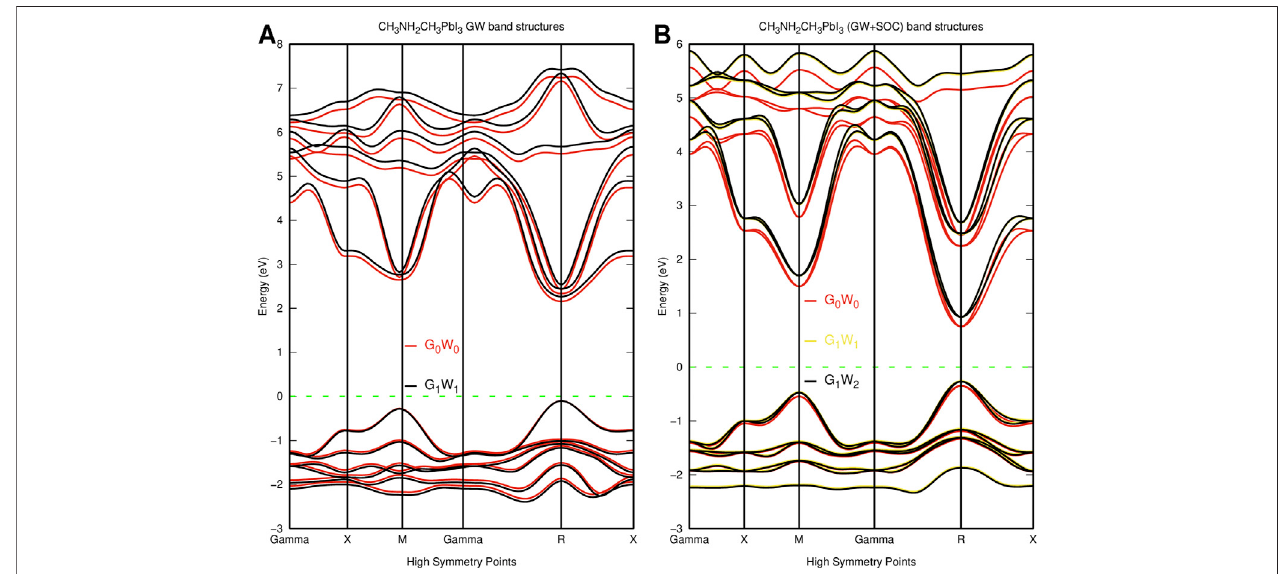
FIGURE 3 | GW band structure of pseudo-cubic CH 3 NH 2 CH 3 PbI 3 . (A) GW band structure of CH 3 NH 2 CH 3 PbI 3 . (B) GW + SOC band structure of